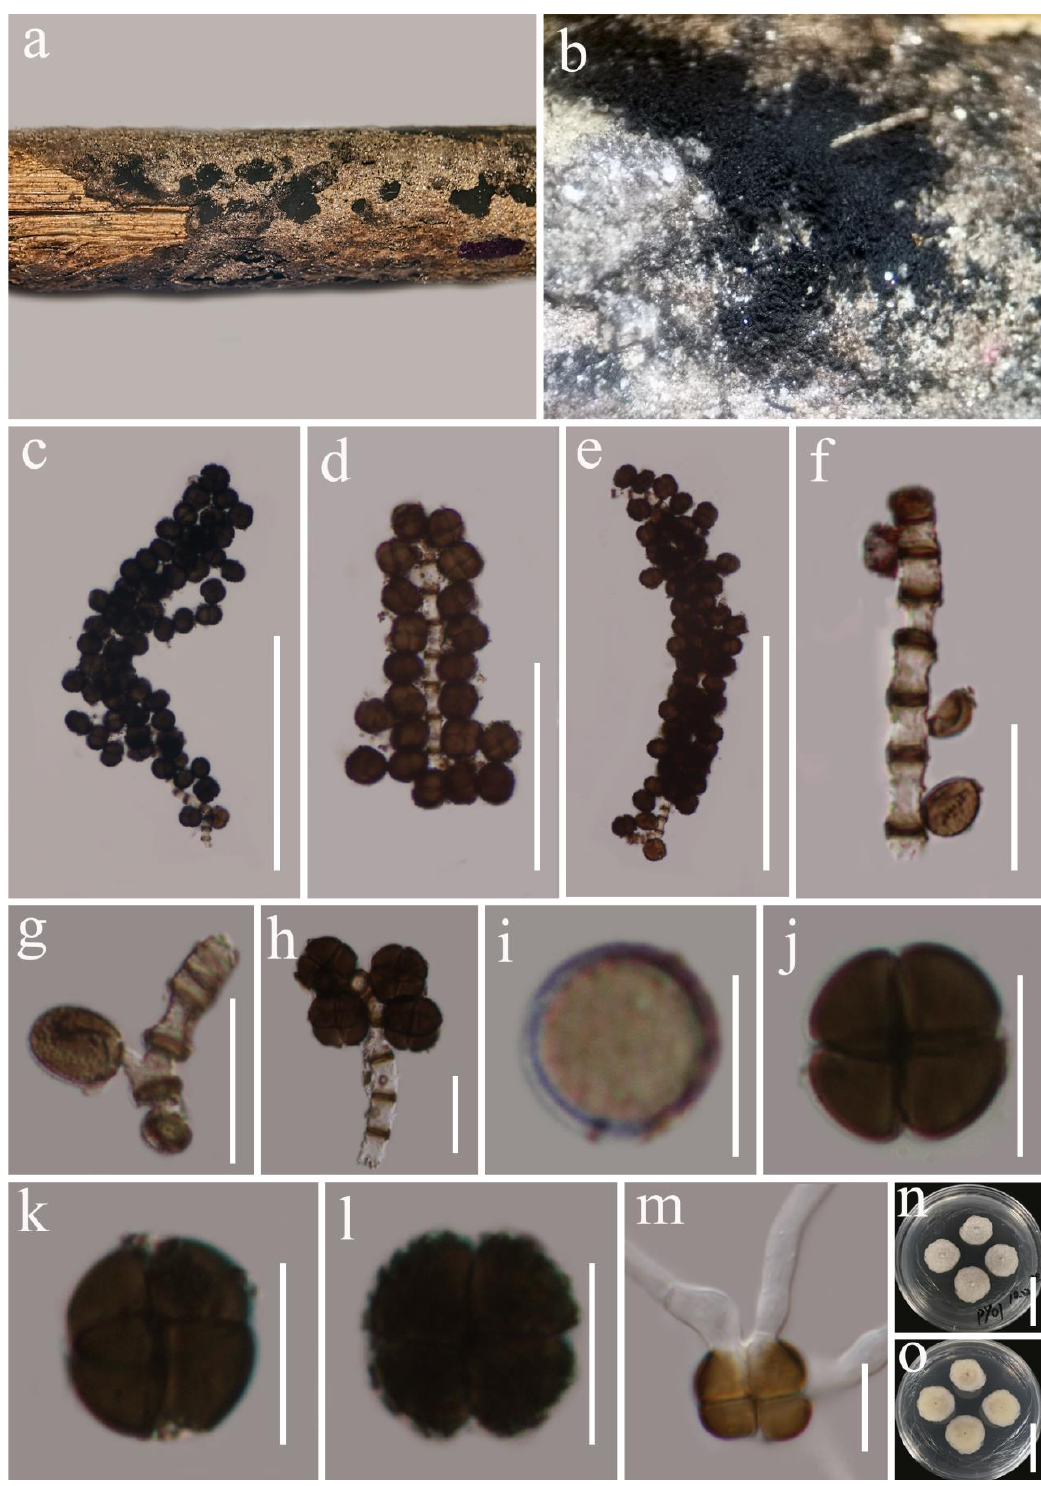
Figure 5. Dictyoarthrinium thailandicum (MFLU 22-0040, holotype). ( a , b ) Conidia on the host; ( c – e ) conidia with conidiophores on stalk; ( f , g ) developmental stage of an immature lateral conidium; ( h ) four-celled terminal conidium; ( i – l ) warted four-celled mature conidia; ( m ) germinated conidia; ( n , o ) culture characters on PDA. Scale bars, ( c , e ) 100 μm; ( d ) 50 μm; ( f – h ) 15 μm; ( i – m ) 10 μm; ( n , o ) 30 mm. Karstenula Speg., Decades Mycologicae Italicae 7 – 12: no. 94 (in sched.) (1879).